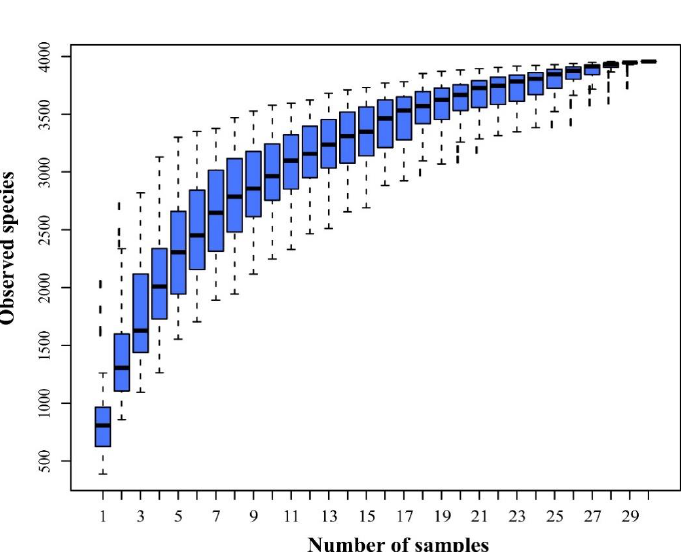
Figure 2. Species accumulation boxplot for sequencing samples of S. palustre in the Erxianyan peat- land. Of 38 detected phyla, Acidobacteria, Actinobacteria, Bacteroidetes, Cyanobacteria, Firmicutes, Proteobacteria and Gemmatimonadetes were distributed as common phyla in all samples. Further analysis indicated that Proteobacteria was the dominant phylum, ac- counting for 48.26 and 33.69% of total reads and OTUs. It was subdivided into three clas- ses: gamma, alpha and delta. The top 8 phyla (the relative abundance > 1%) occupied 78.31% of the total OTUs, including Proteobacteria (33.69%, 1337 OTUs), Firmicutes